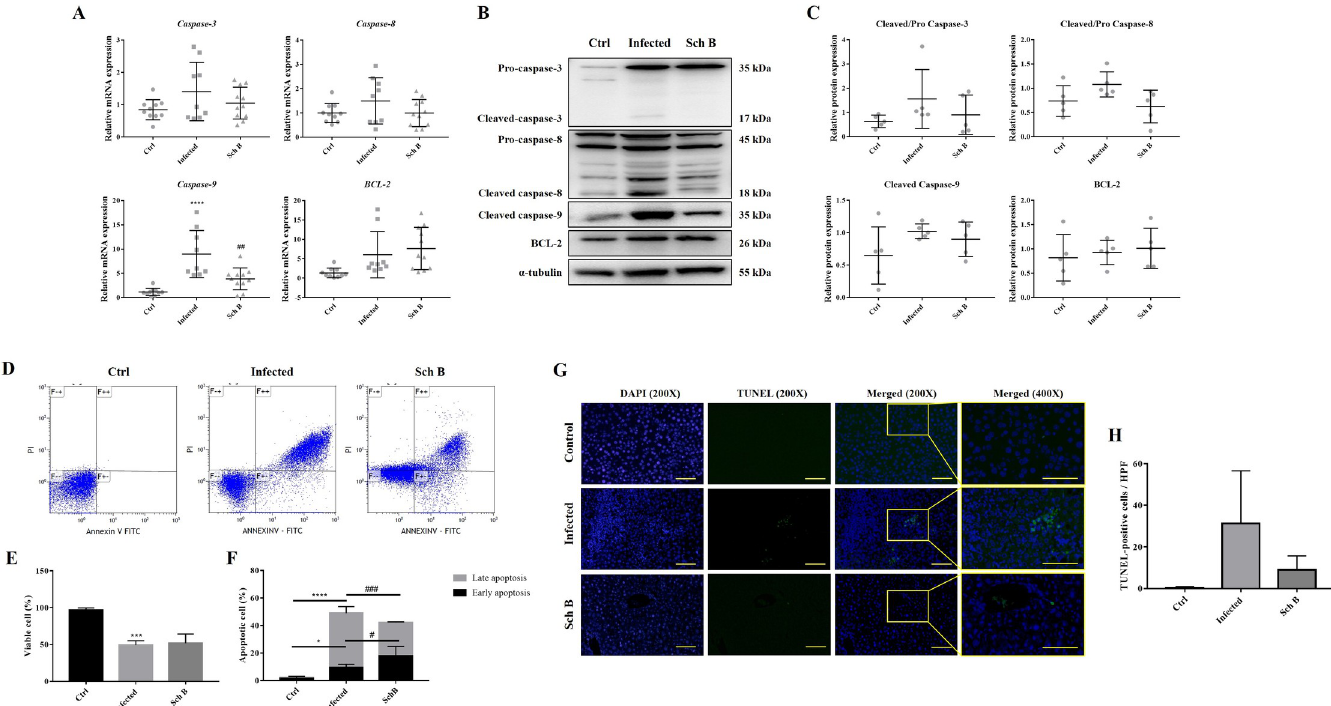
Fig 5. Sch B inhibits apoptosis in S . mansoni -infected mice. (A) RNA transcription levels of apoptotic markers. Data are presented as mean ± S.D. (n = 9–11). (B) Representative western blot images showing protein levels of apoptotic markers. (C) Protein expression levels of apoptotic markers, relative to that of α -tubulin. Results are presented as mean ± S.D. (n = 5). (D) Representative plots showing Annexin V-FITC and PI double staining, measured by flow cytometry. Viable cells are shown in the bottom left quadrant (double negative); early apoptotic cells are shown in the bottom right quadrant (Annexin V positive and PI negative); late apoptotic cells are shown in the upper right quadrant (double-positive). (E) Percentages of viable cells, shown as the mean ± S.D. (n = 5). (F) Percentages of apoptotic cells are shown as the mean ± SD (n = 5). (G) Representative microphotographs of TUNEL staining, shown at 200 × and 400 × magnifications. Scale bar corresponds to 100 μ m. (H) Quantification was performed on three slides in each group. Ten random microscopic fields were counted on each slide. � P -value < 0.05, ��� P -value < 0.001, and ���� P -value < 0.0001 compared with control group; # P -value < 0.05, ## P -value < 0.01, and ### P -value < 0.001 compared with infected group.